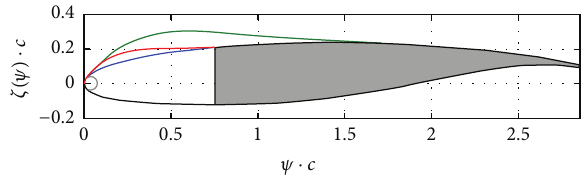
Figure 7: Comparison between a generic airfoil (black), its param- eterization (blue), and corresponding shapes obtained introducing the same perturbation with (red) and without (green) solving the reduced system.